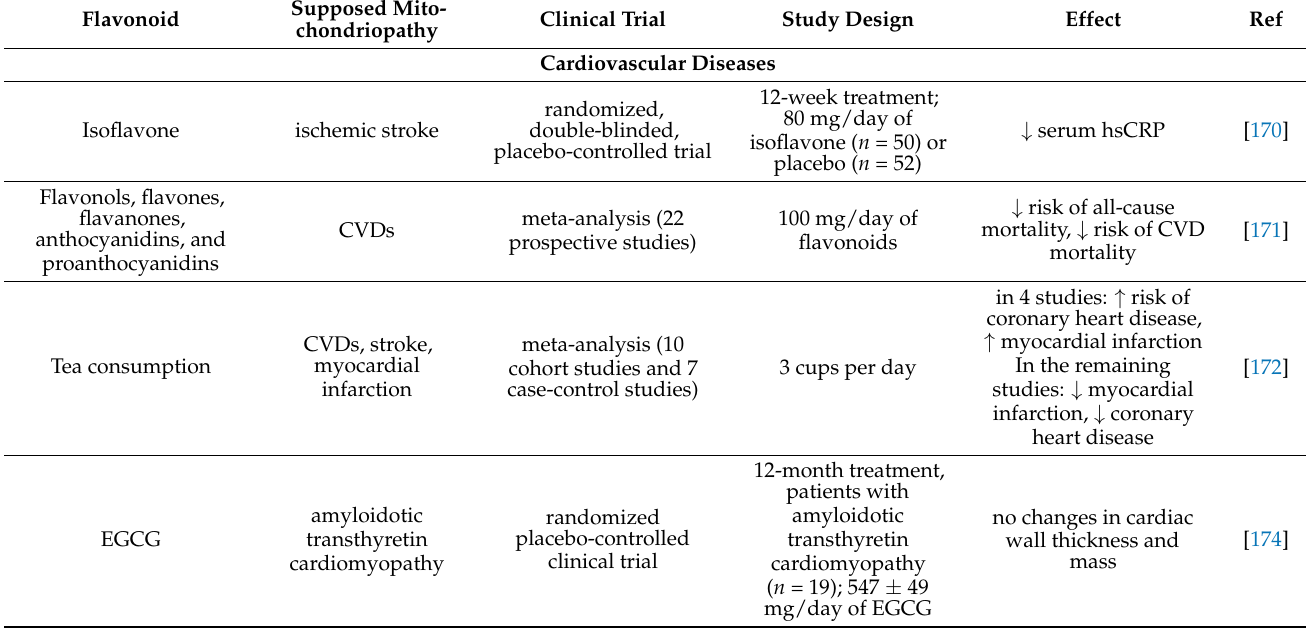
Table 2. Effects of flavonoids in the etiology of mitochondriopathies (cancer, CVDs, and neurodegenerative disorders).